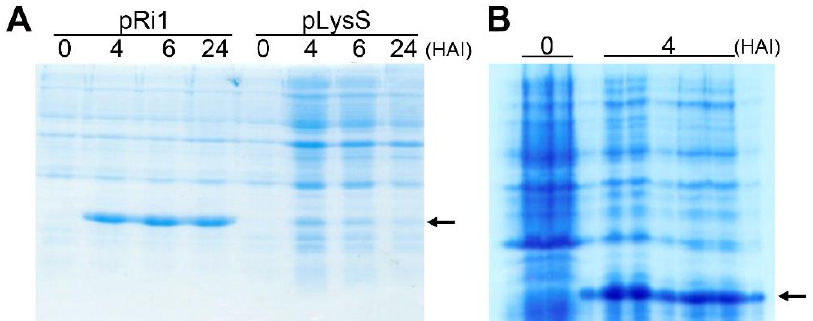
Figure 4. ScRpb4 protein expression analysis in small and large scale using different expression Escherichia coli strains. ( A ) pET-28a::Rpb4 small scale expression at 37 °C. ( B ) pET-28a::Rpb4 large scale expression in pRil cells at 37 °C for 4 h. Protein expression induction was conducted with 100 μM IPTG and evaluated using 15% SDS-PAGE. The arrow indicates 19 kDa, the size of 6His-ScRpb4 recombinant protein. HAI, hours after IPTG induction.